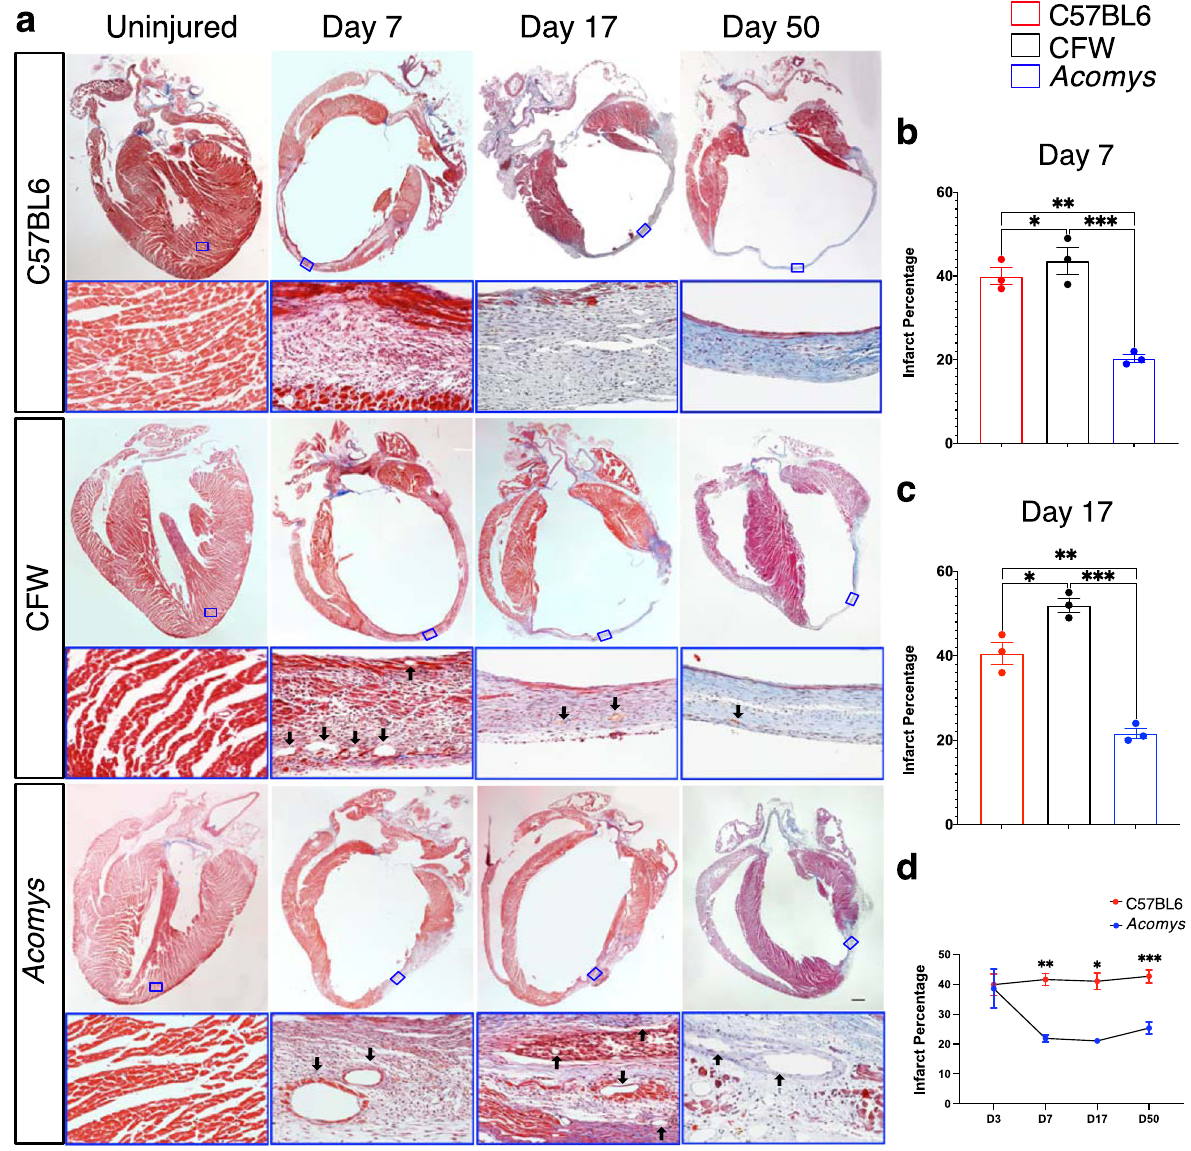
Fig. 6 Cardiac scar tissue exhibits limited expansion in Acomys . a Representative images of Masson ’ s trichrome stained long-axis left ventricular cavity sections of Mus (C57BL6 and CFW) and Acomys in uninjured and MI animals at 7-, 17- and 50-days post-MI showing the progression of scar across species (scale bar = 500 μ m). The lower panels represent the boxed areas and show the composition of the scar at each stage. b , c Quanti fi cation of the infarct size, corresponding to the ratio between infarcted length and left ventricular length showing signi fi cantly smaller scar in Acomys compared to Mus strains ( N = 17 Mus -C57BL6, 11 Mus -CFW, and 5 Acomys , values are means ± S.E.M, * P < 0.05 by one-way ANOVA and Tukey ’ s multiple comparison test). d Scar progression in Acomys and Mus -C57BL6 showing dynamic reduction in infarct size in Acomys in contrast to the larger static scar in Mus -C57BL6 (* P < 0.05, ** P < 0.01, and *** P < 0.001 as analyzed using 2-way independent